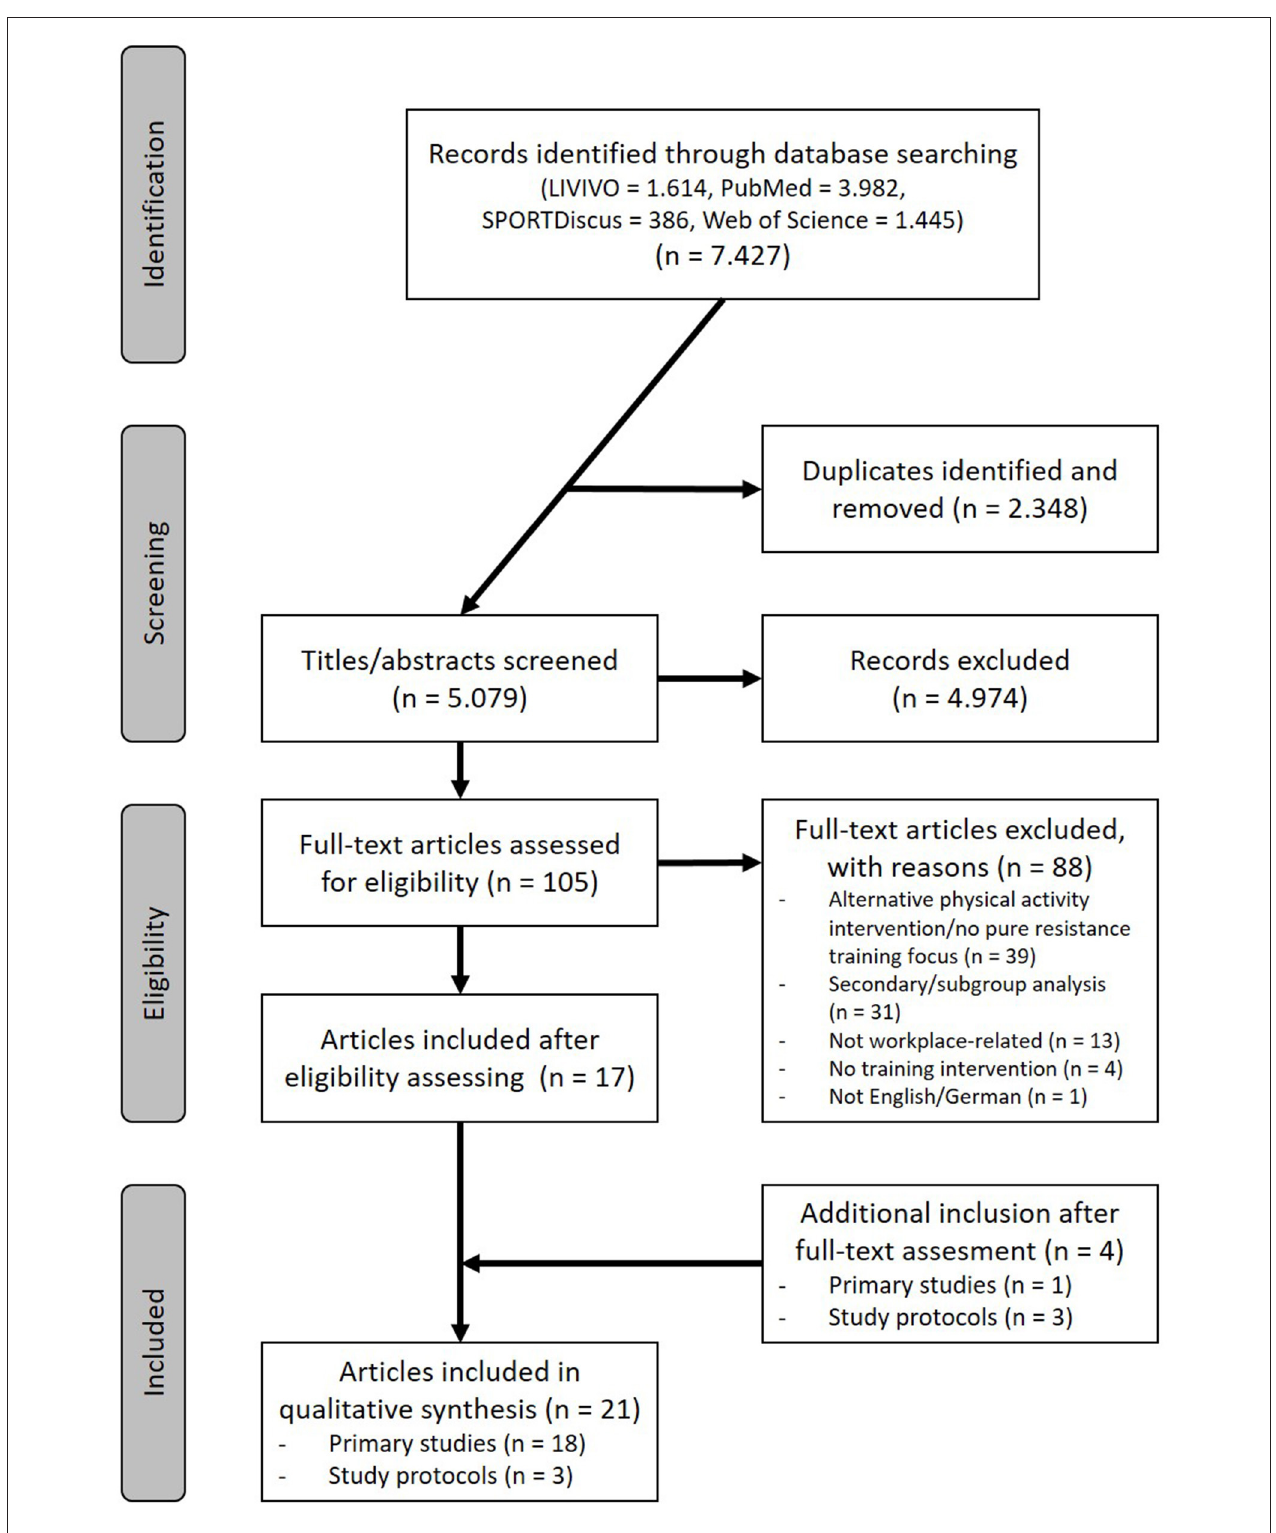
FIGURE 1 | Flow diagram illustrating the search and selection process.